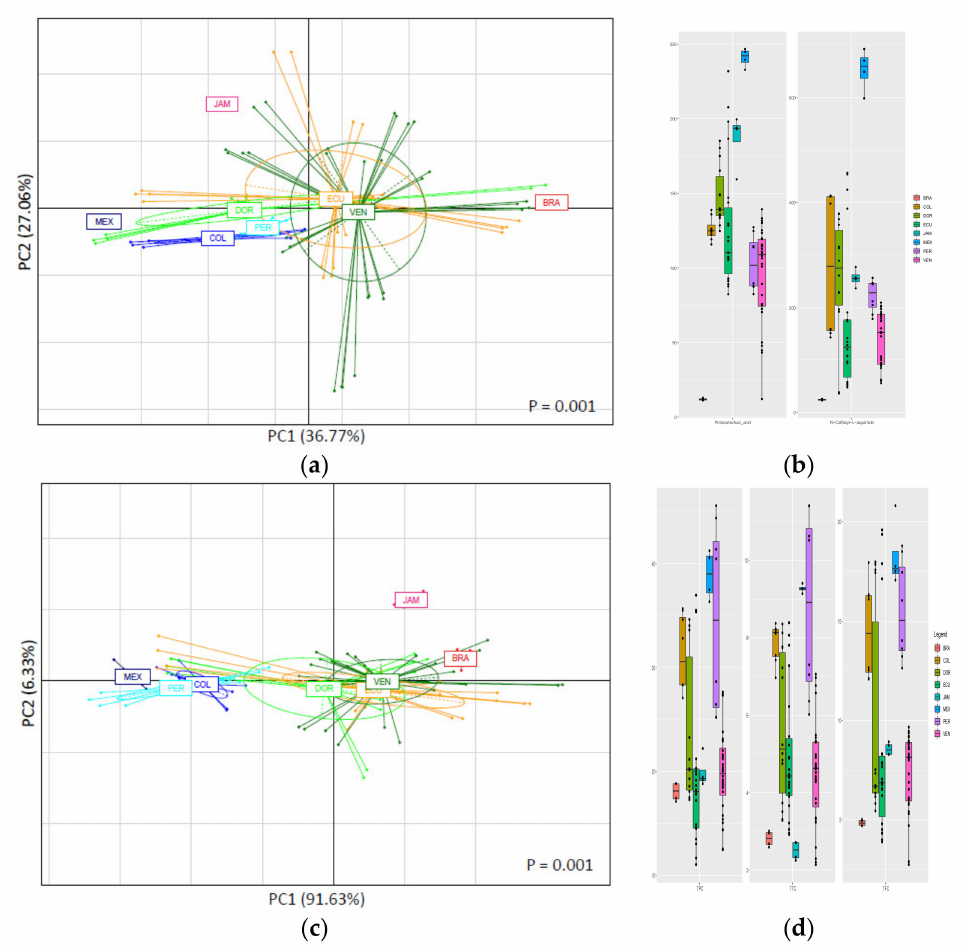
Figure 3. PCA based on HPLC-determined polyphenolic profile ( a ) and spectrophotometric analyses results ( c ) as function of country of origin among American CBS. Variance explained by first and second components of PCA is shown in parenthesis for PC1 and PC2 in each graph. Boxplots showing abundance of two key polyphenolic compounds (protocatechuic acid and N -caffeoyl-L-aspartate) ( b ) and TPC, TTC and TFC ( d ) that can be used as possible markers for separation based in country of origin are shown next to their correspondent PCA graph. For interpretation of legends, see Table